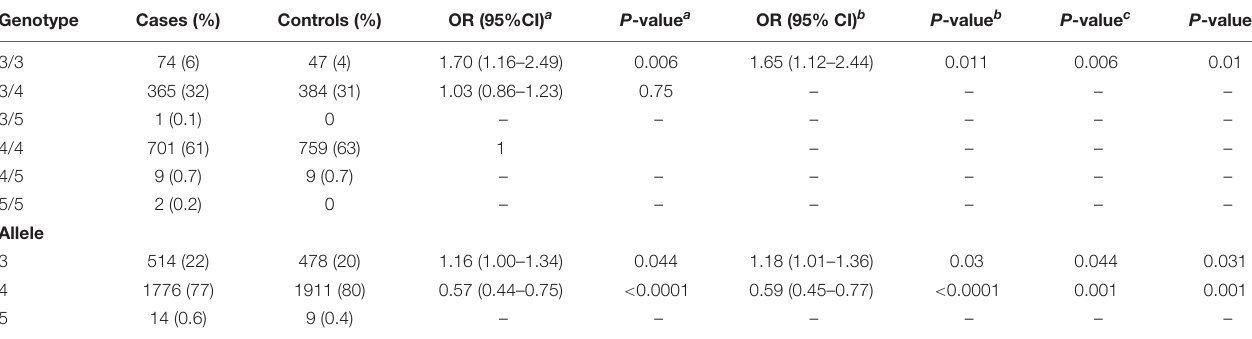
TABLE 2 | Allele and genotype risk association analysis of TTTTG -TRIB1 STR with prostate cancer risk.